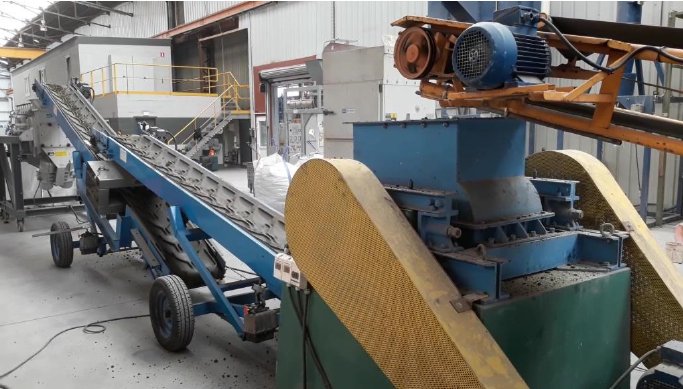
Figure 13. Step of toothed roll crushing with 10 mm sieve directly connected (in the back).